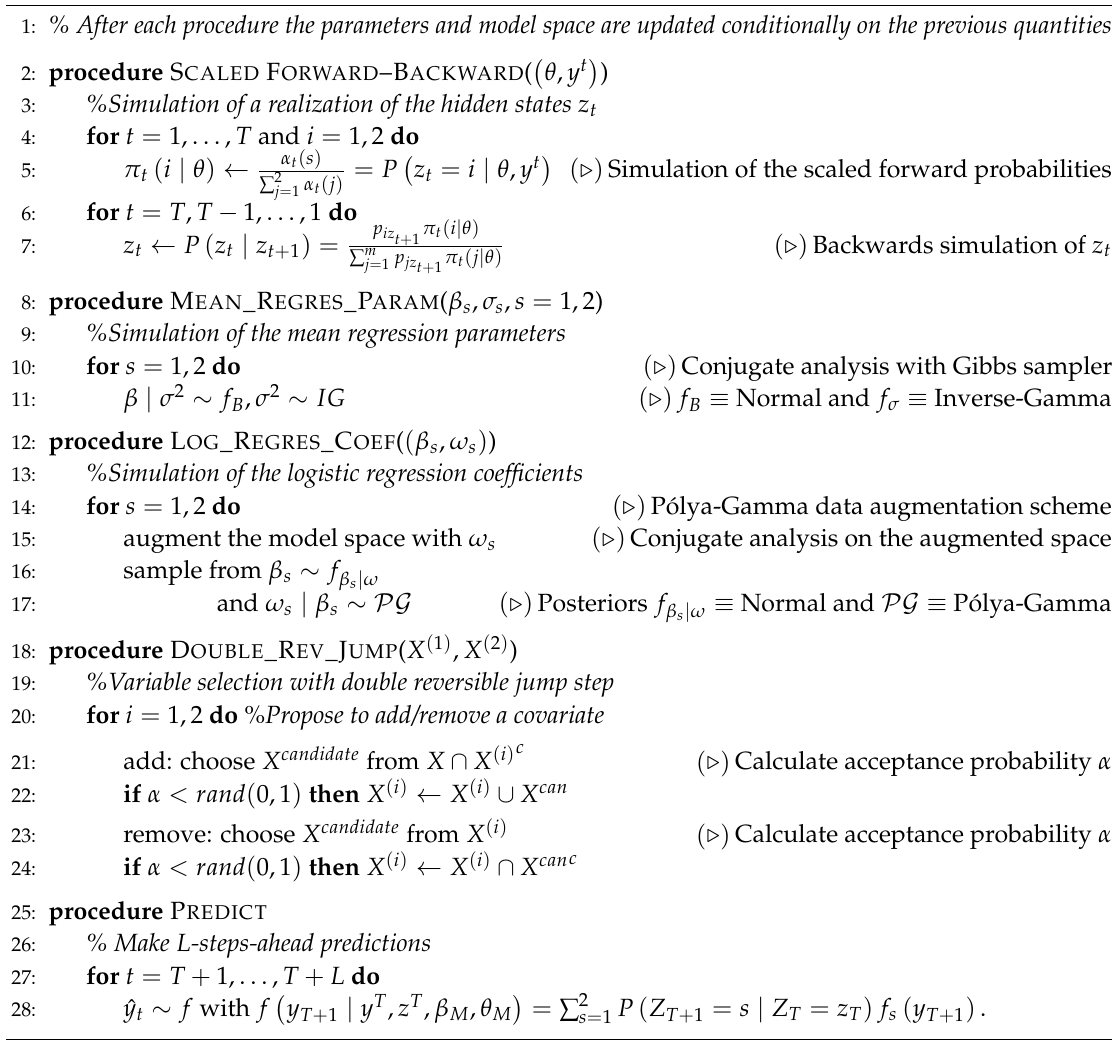
Algorithm 1 MCMC Sampling Scheme for Inference on Model Specification and